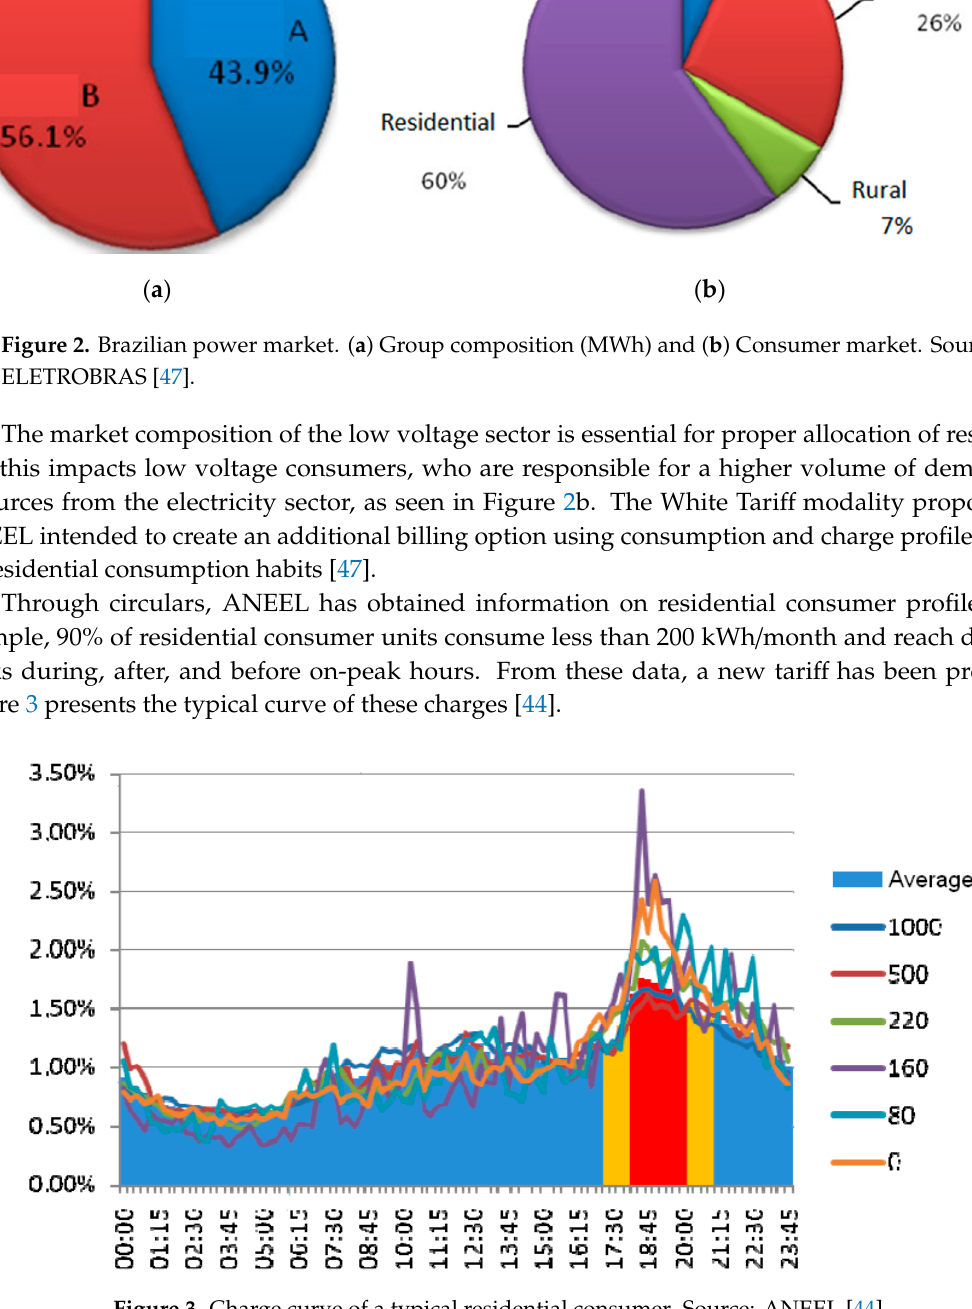
Figure 3. Charge curve of a typical residential consumer. Source: ANEEL [44].